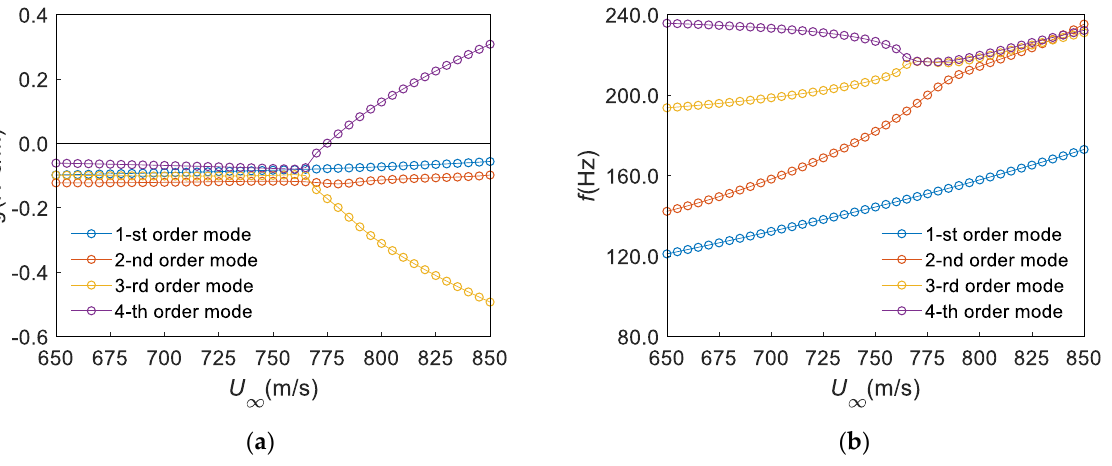
Figure 22. Results of flutter calculation for the panel with no mass attachment (QP) ( Ma ∞ = 2.0):